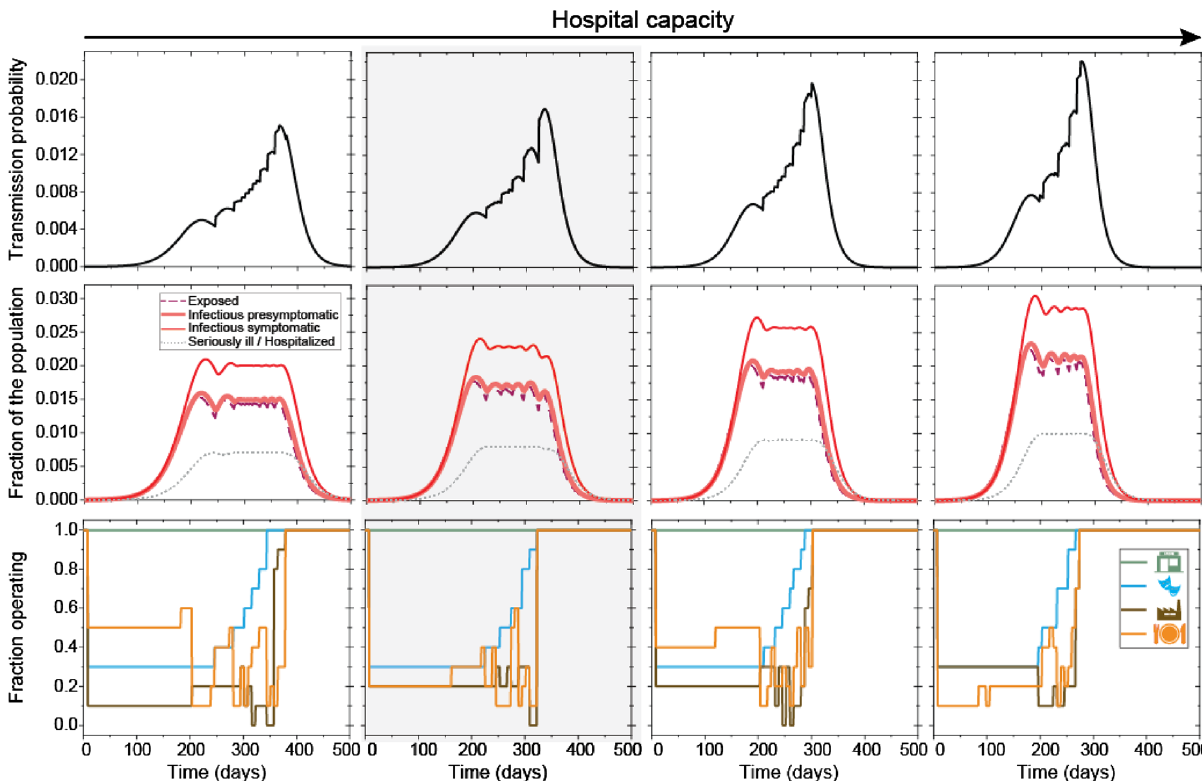
Figure 4. The effect of the number of available hospital beds on the course of the controlled epidemic. Transmission probability (first row) can be controlled by the selective (partial) closing or opening of certain venues (economic sectors) (last row). With more available hospital beds (columns, increasing from left to right), the epidemic lasts for a shorter time (middle row). Patients in the I ps stage infect on average 4.5 individuals; hospital capacity is Y 3 = 70, 000 ; 80, 000 ; 90, 000 and 100, 000 in the columns, respectively. Results with shaded backgrounds correspond to the solution of the game, which is also depicted in Fig. 3. Parameters are otherwise as in Fig.